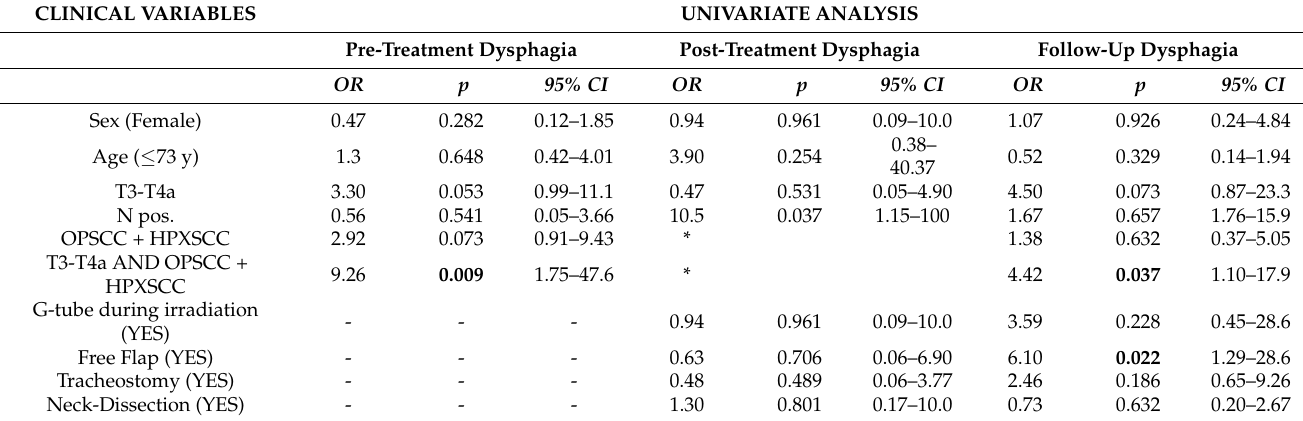
Table 3. Binary Logistic Regression Analysis for Dysphagia.